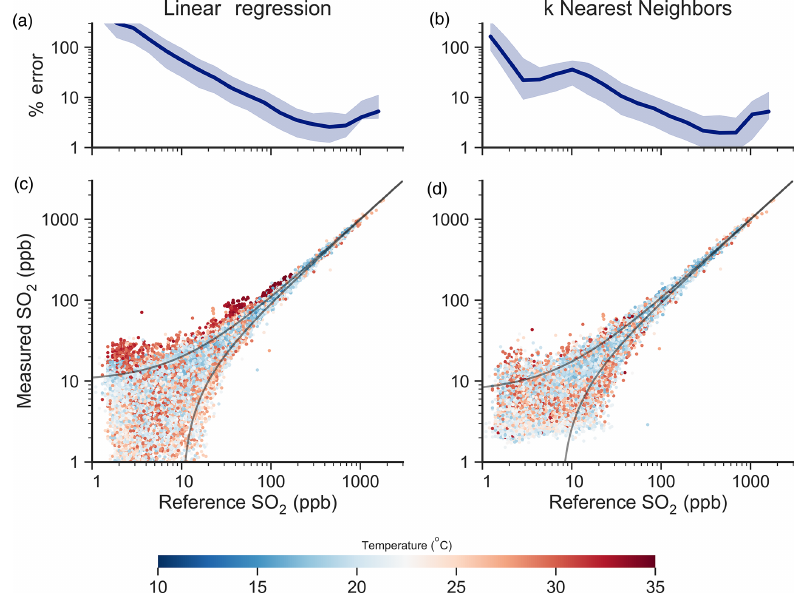
Figure 5. Validation results using multivariate linear regression (a, c) and k nearest neighbors regression (b, d) . Data are shown as the SO 2 measurement by a single sensor (SO2-02) vs. the reference measurement from the AQ station, colored by T . Relative error (a, b) is shown as a function of observed SO 2 concentration (the interquartile range is shown as the shaded region). Data shown are for the test set only, made up of 30% of data collected over the entire measurement period (15 January to 25 April 2017, n = 125258). Results for other sensors are given in Table 1. Table 1. Summary of calibration results for all sensors deployed in this study. Linear regression b k nearest neighbors b Hybrid regression c Node no. N a MAE RMSE r 2 MAE RMSE r 2 SO2-01